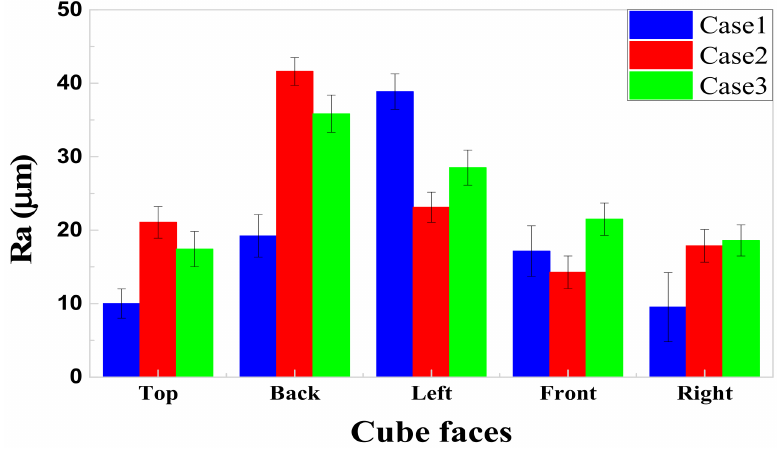
Figure 6. The roughness with different scan